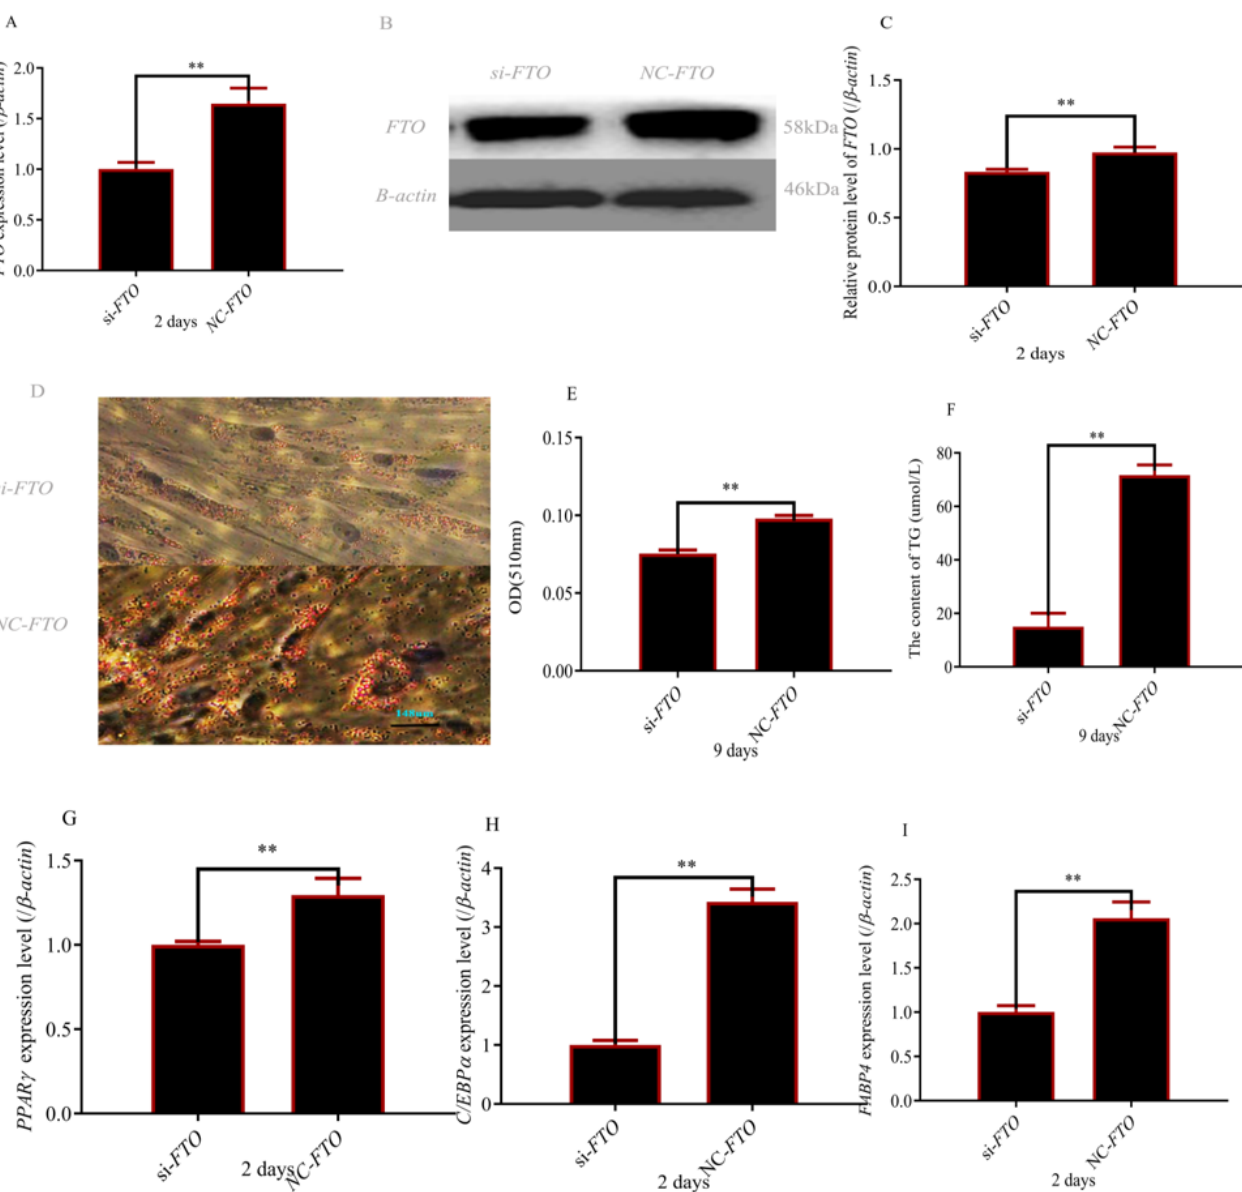
Figure 2. Interference of FTO reduced preadipocyte differentiation: ( A ) FTO expression level after transfecting with si-FTO and NC; ( B,C ) FTO protein level after transfecting with si-FTO and NC; ( D ) lipid droplets (magnifications = 10 × 10); ( E ) lipid droplet content; ( F ) Triglyceride content; ( G – I ) PPARγ , CEBPα and FABP4 expression after transfecting with si-FTO and NC ( ** p ≤0.01) .